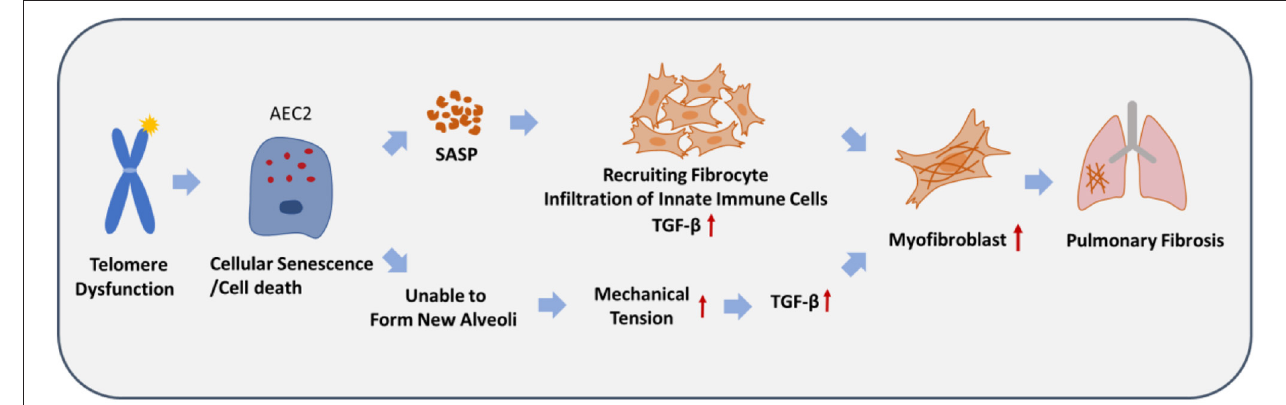
FIGURE 2 | A proposed model to depict the pathogenesis of idiopathic pulmonary fibrosis caused by telomere dysfunction. Telomere dysfunction causes cellular senescence and/or cell death of alveolar epithelial type 2 cells (AEC2s), which leads to the production of a pro-fibrotic niche, mediated by the SASP. This probably leads to increased mechanical tension and a TGF- β signaling loop in a spatially distributed manner in the lung, owing to the inability to form new alveoli. Eventually, pulmonary fibrosis develops due to the significant increase in